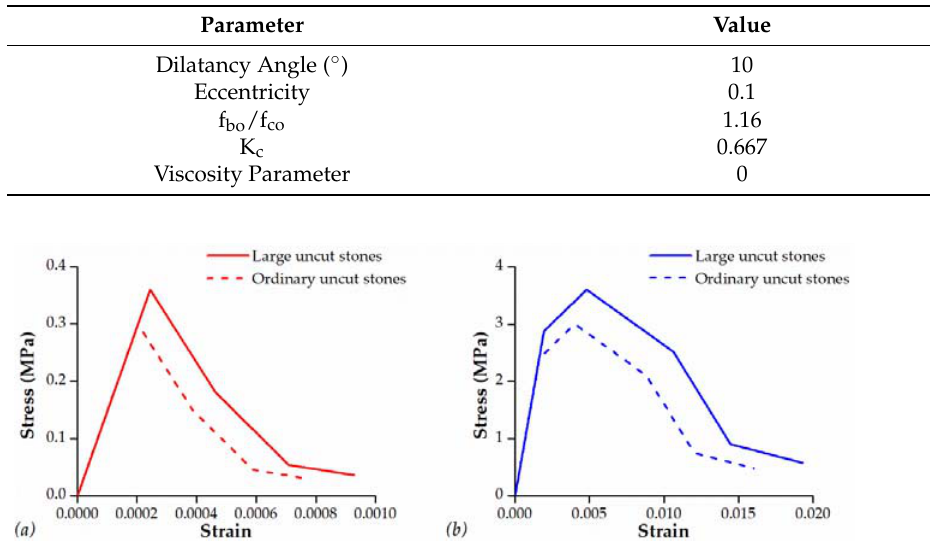
Figure 8. Nonlinear uniaxial stress–strain behavior assigned to masonry in ( a ) tension and ( b ) Figure 8. Nonlinearuniaxialstress–strainbehaviorassignedtomasonryin( a )tensionand( b compression.